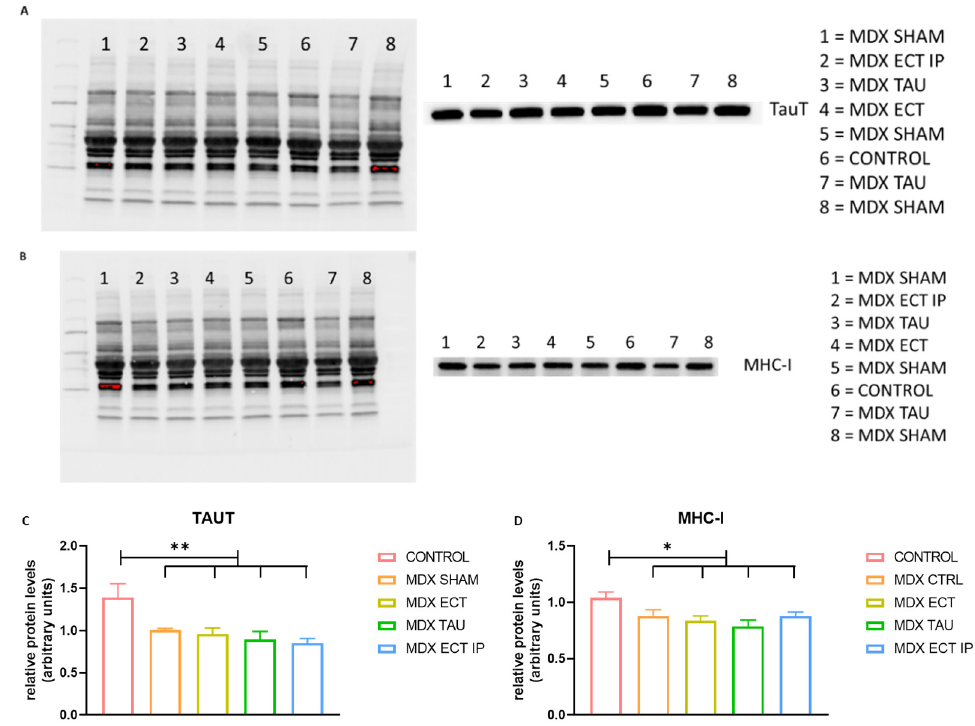
Figure 7. Protein expression of TauT and MHC-I in control and mdx mice. ( A ) Representative images of the Stain-Free blot (left) used for total protein normalization and TauT protein bands (right) as imaged through chemiluminescent detection. ( B ) Representative images of the Stain-Free blot (left) used for total protein normalization and MHC-I protein bands (right) as imaged through chemiluminescent detection. ( C ) Graphical representation of TauT protein levels in control and treated mdx mice after normalization against total protein using Bio-Rad stain-free gels. ( D ) MHC-I protein levels in control and treated mdx mice after normalization against total protein. Data are presented as mean ± SEM. Statistical analysis evaluated differences between sham-treated mdx mice and other groups or between control mice and other groups. Significant differences are annotated by * ( p < 0.05); ** ( p < 0.01).